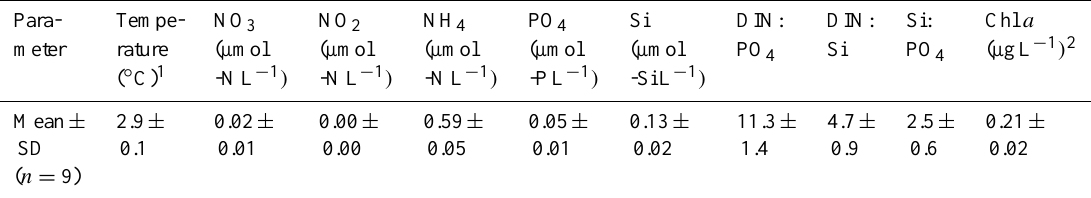
Table 2. Initial condition in the nine mesocosms. Data on t 0 are shown as a reference (Schulz et al., 2012). DIN (dissolved inorganic nitrogen) is the sum of NO 3 , NO 2 , and NH 4